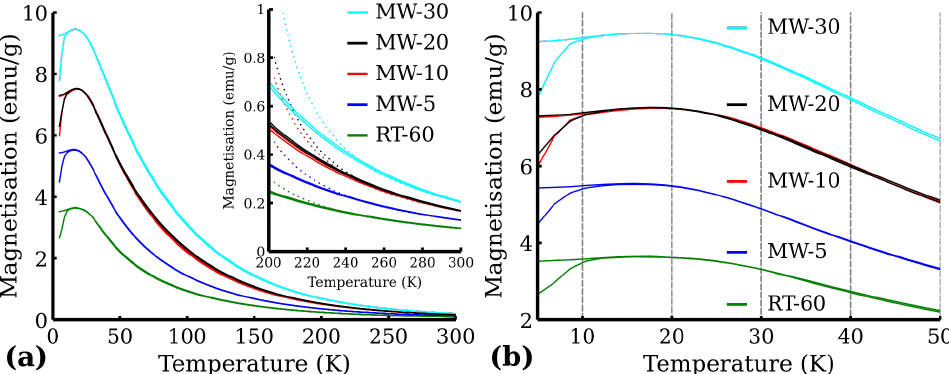
Figure 11. ZFC and FC (1000Oe) magnetization curves: ( a ) 5K to 300K range and ( b ) 5K to 50K range. Dotted lines correspond to the Curie–Weiss law